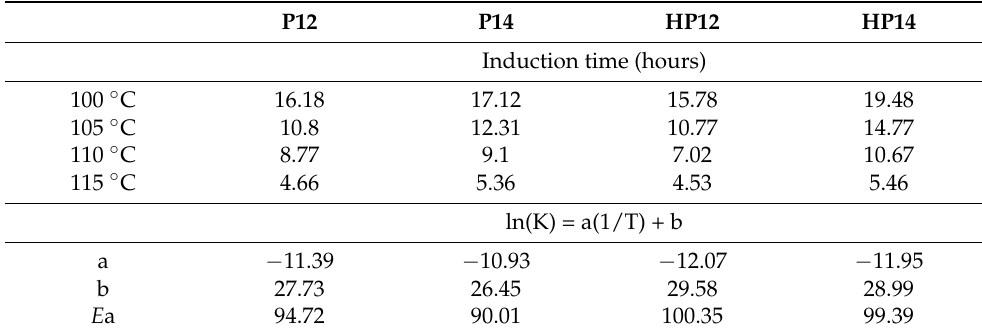
Table 3. Regression parameters for the Arrhenius relationships between the reaction rate constant and the temperature for P12, P14, HP12, and